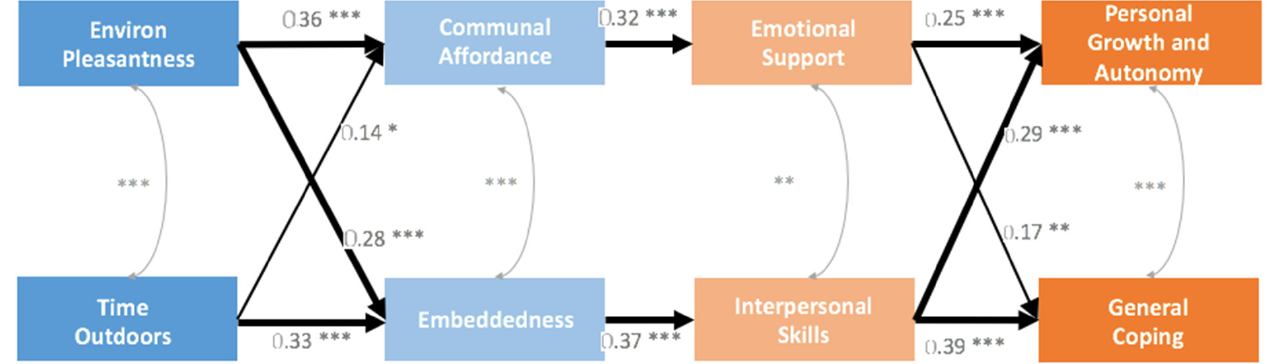
Figure 3. Neighborhood health processes, as shown in path analysis from factors of neighborhood cohesion to factors of positive mental health. Path coefficients are shown (n = 202; *** p < 0.001; ** p < 0.01; * p < 0.05). Embeddedness = Neighborhood Friendship. Acceptable goodness-of-fit indices were found. In both models, comparative fit index (CFI) and Tucker–Lewis index (TLI) were 0.97 and 0.94, respectively, above the acceptable value of 0.90; root mean square error of approximation (RMSEA) was 0.04 with an upper bound of 0.08, whereas standardized root mean square residual (SRMR) was 0.04, both below the acceptable threshold of 0.10; chi-square was also not significant, as would be required for good model fit [42]. Similar model fit was found for the third model (TLI = 0.996, CFI = 0.994, RMSEA = 0.01, SRMR = 0.05, chi-square p -value = 0.406).